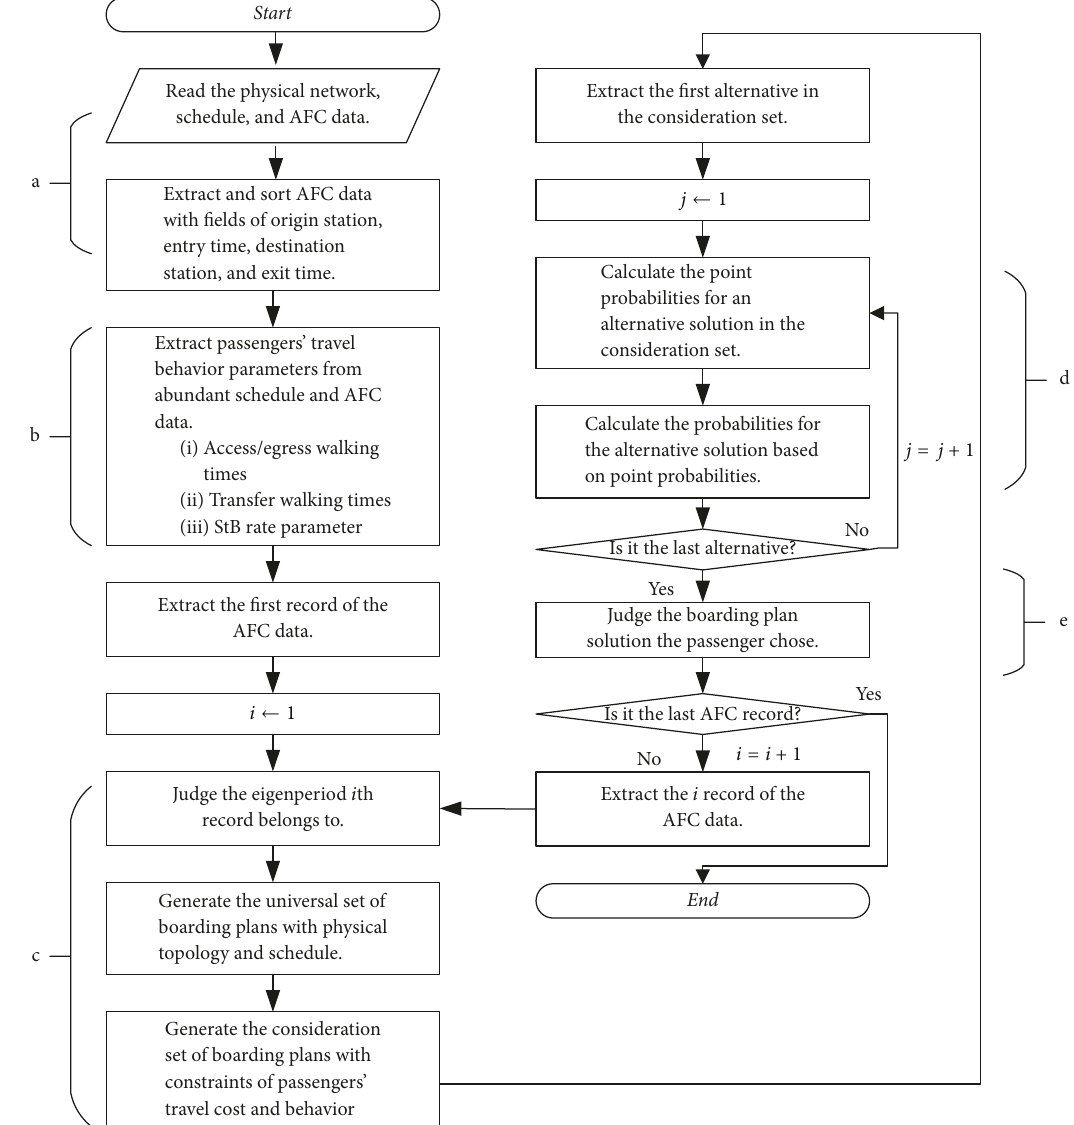
Figure 3: Overall framework of estimation